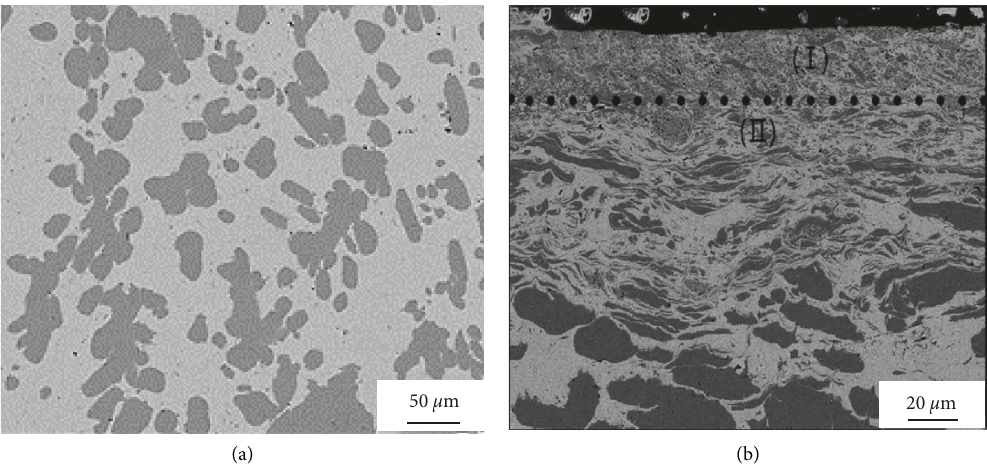
Figure 18: SEM micrograph of a cross section of CuCr alloys sample. (a) Original. (b) SMAT—5 h sample [61].